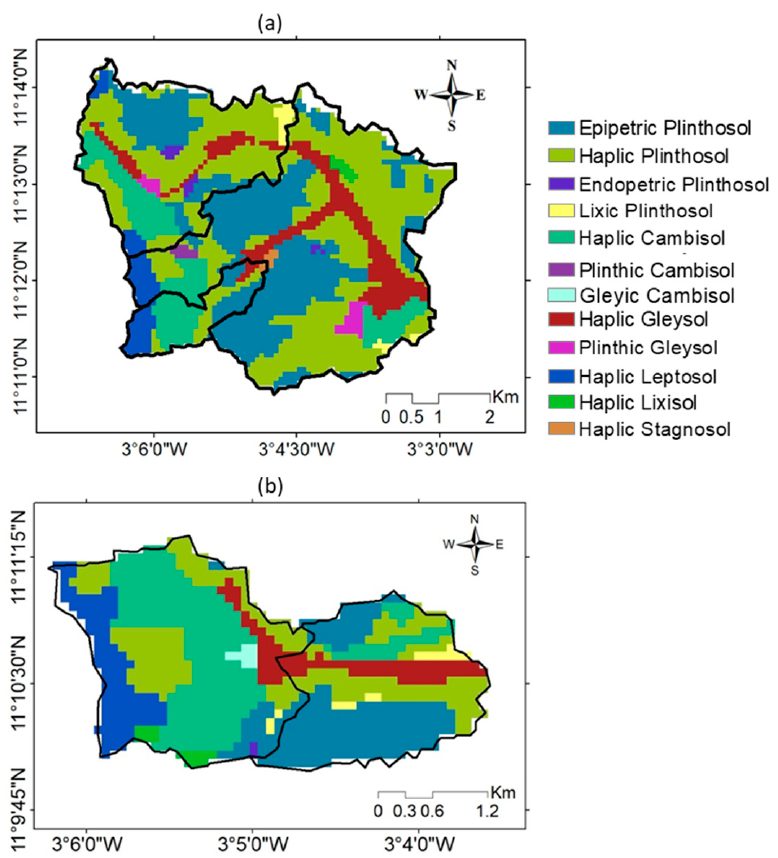
Figure 2. Soil maps of the investigated catchments. ( a ) Bankandi ‐ Loffing, ( b ) Mebar (Dataset: [67]).